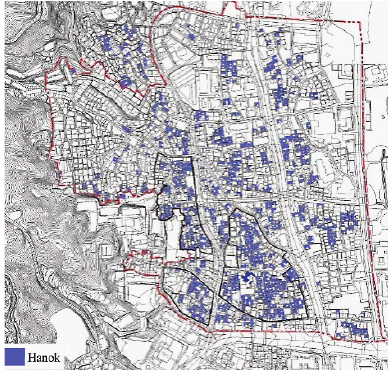
Figure 10. The distribution of hanokin Seochon village (source: Seochon district plan,